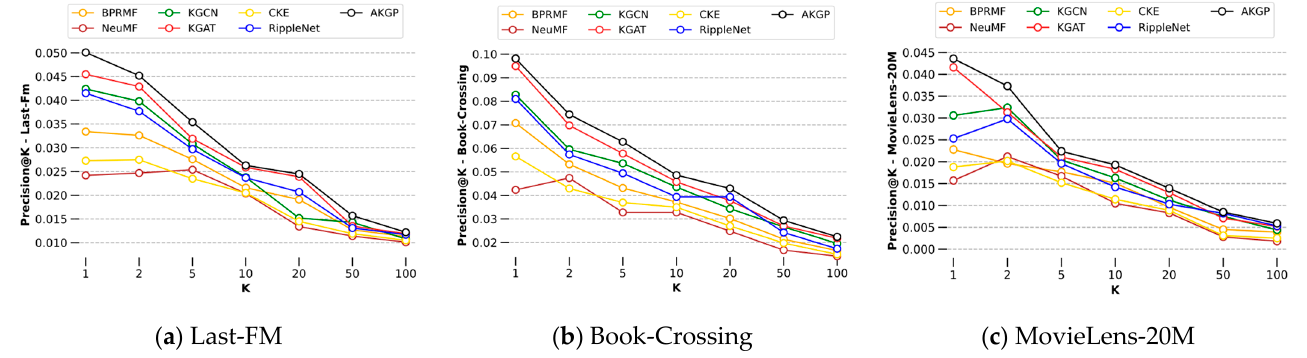
Figure 6. The results of Precision in Top-K recommendation. ( a ) Results using the Last-FM dataset. ( b ) Results using the Book-Crossing dataset. ( c ) Results using the MovieLens-20M